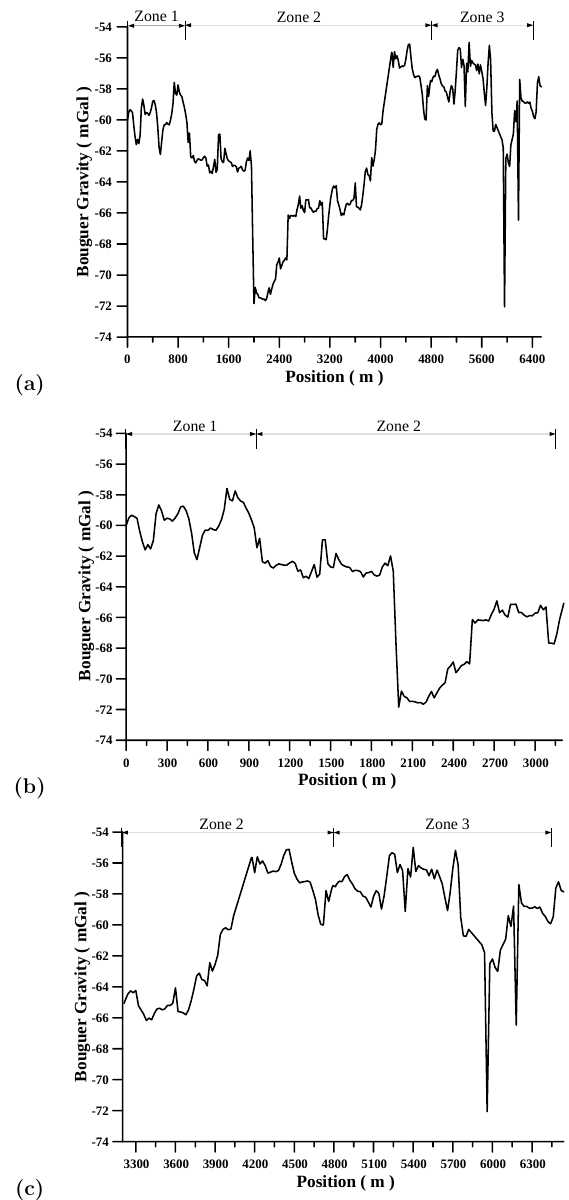
Figure 3. Variation of the Bouguer gravity values along the NNW-SSE profile: (a) for the entire profile; (b) for its northern part; (c) for its southern